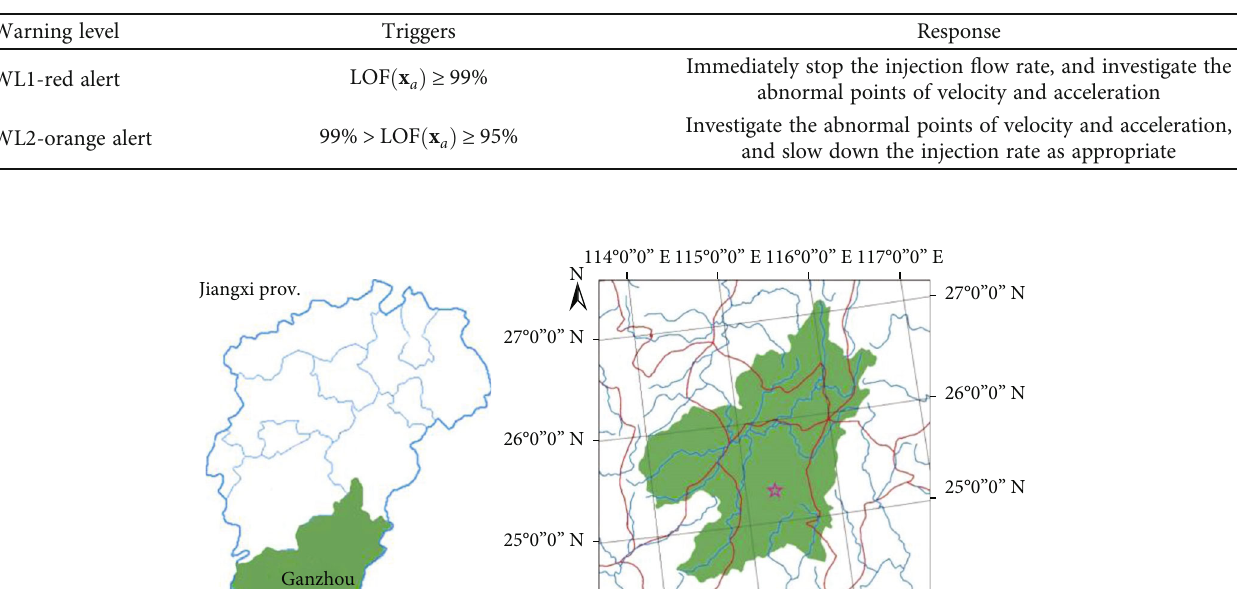
Table 1: Warning levels adopted for the early warning system [28, 31].